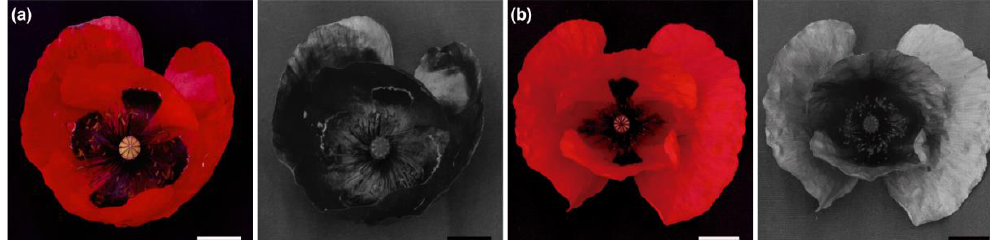
Figure 2. RGB and UV images of flowers of P. rhoeas collected in the North Mediterranean. ( a ) A P. rhoeas flower that reflects negligibly in UV. ( b ) A P. rhoeas flower with appreciable UV reflectance. Scale bars: 1 cm.